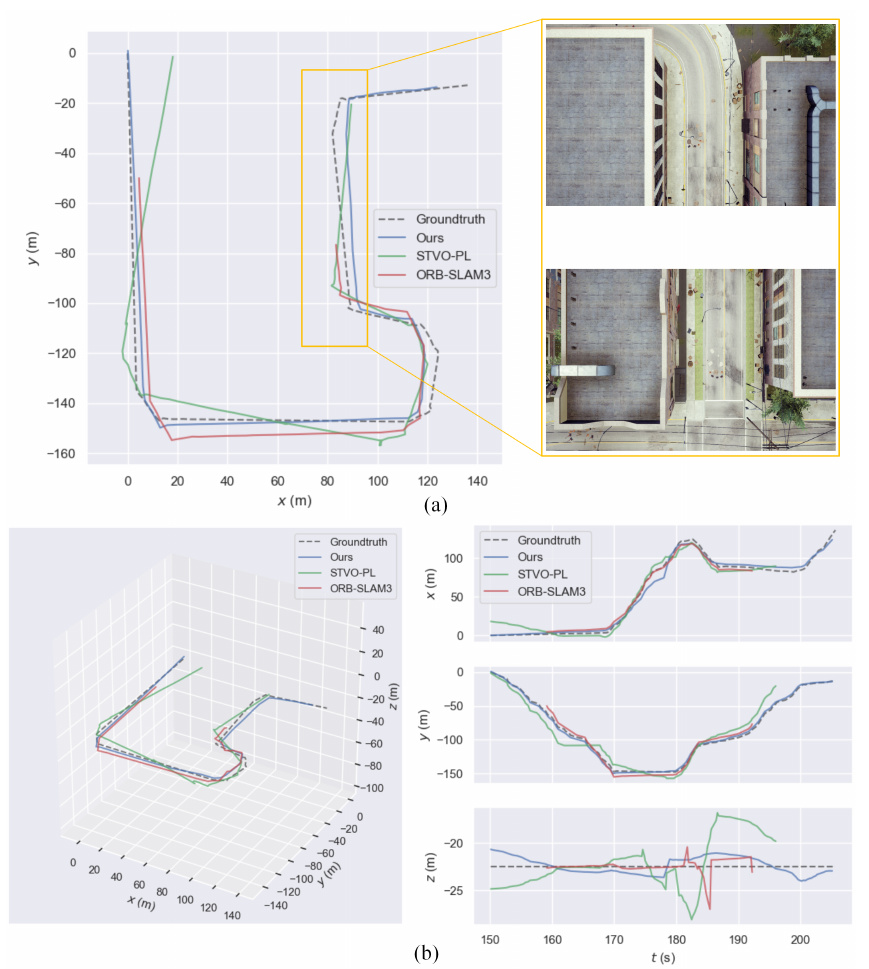
Figure 11. ( a ) Comparison of trajectories against ground truth on the IndustrialCity-downward simulation sequence. ( b ) Comparison of trajectories on the IndustrialCity-downward simulation sequence on xyz